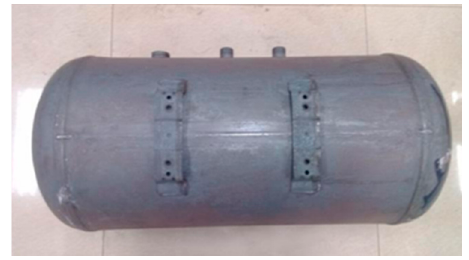
Figure 13. Electric water heater tank after enameling.